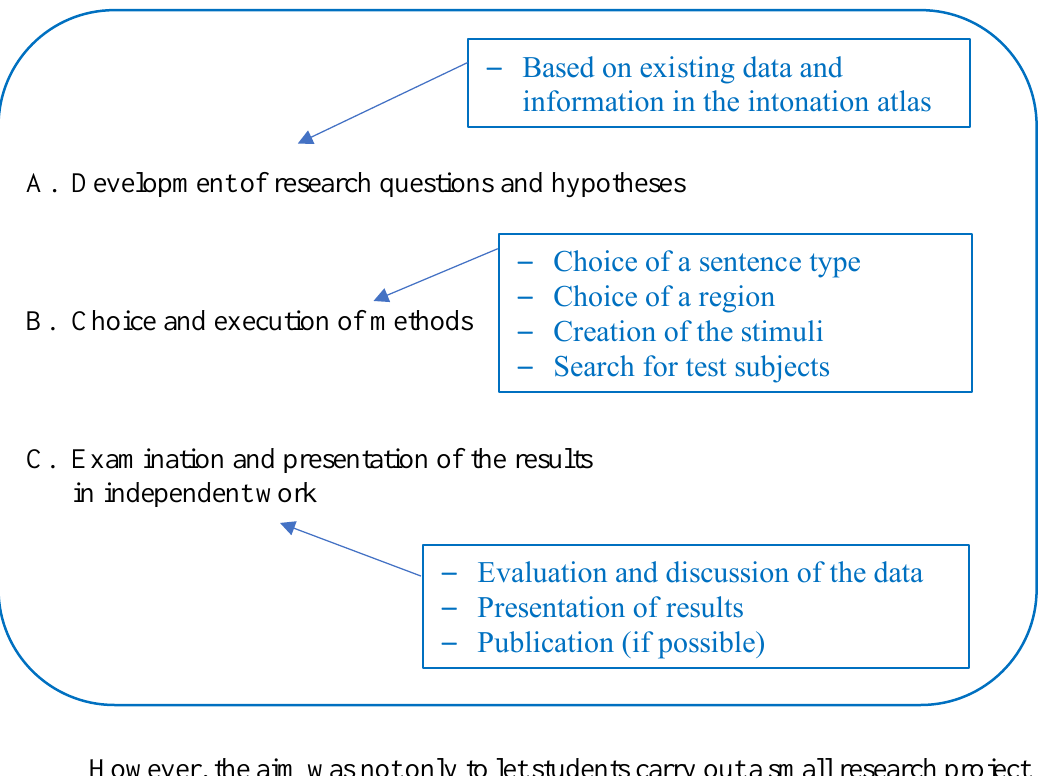
A. Development of research questions and